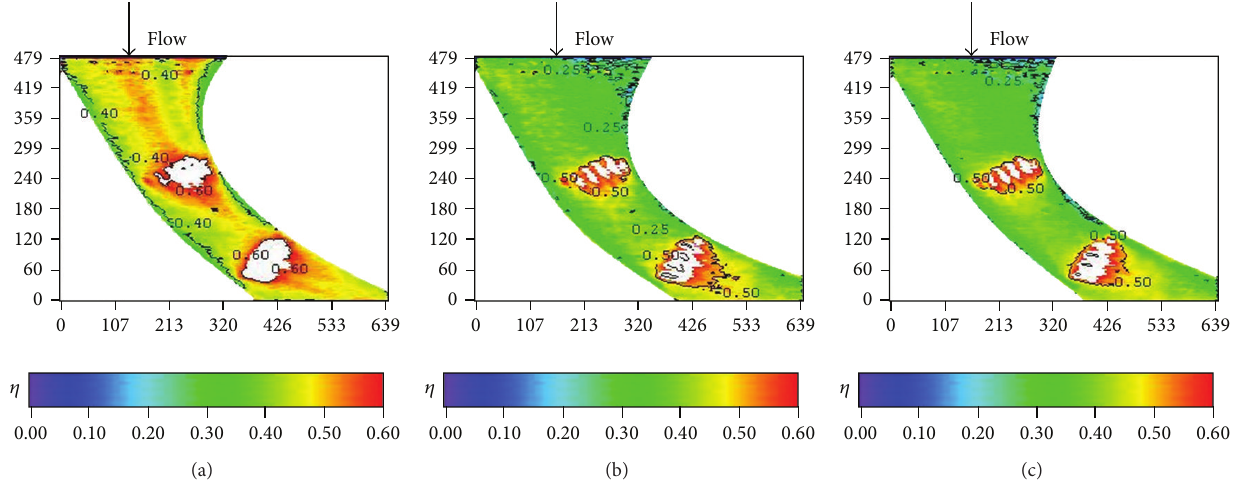
Figure 18: Effect of turbulence intensity on effectiveness distributions for nonstepped endwall (Re = 124000 , 𝑀 = 2 , and 𝑆/𝐶 = 0 %). (a) T . I . = 1.8 %. (b) T . I . = 7 %. (c) T . I . = 12 %.